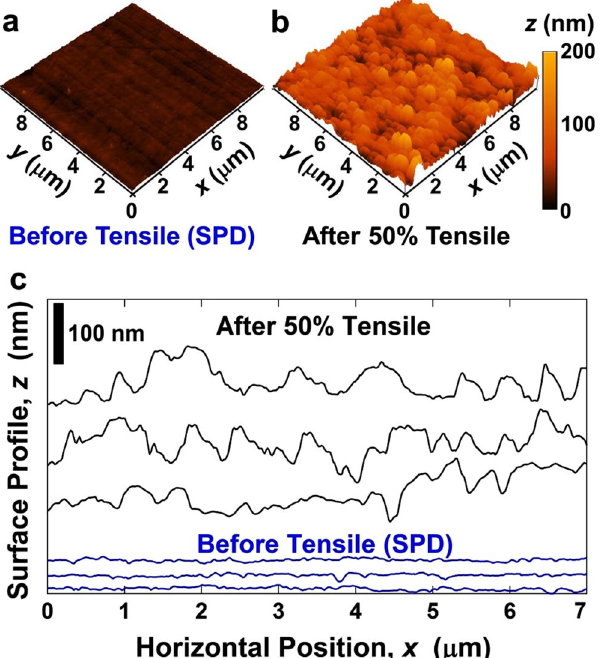
Figure 2. The surface of tensile sample becomes rougher and the average step size perpendicular to the surface increases by ~60 nm after pulling the sample for 50%, indicating the occurrence of grain-boundary sliding. Surface profile before and after tensile test for 50% elongation under a strain rate of 5.5 × 10 − 5 s − 1 for the sample processed by SPD. ( a , b ) AFM images showing the surface roughness. ( c , d ) Plots of surface profiles on three different areas of sample achieved by AFM line